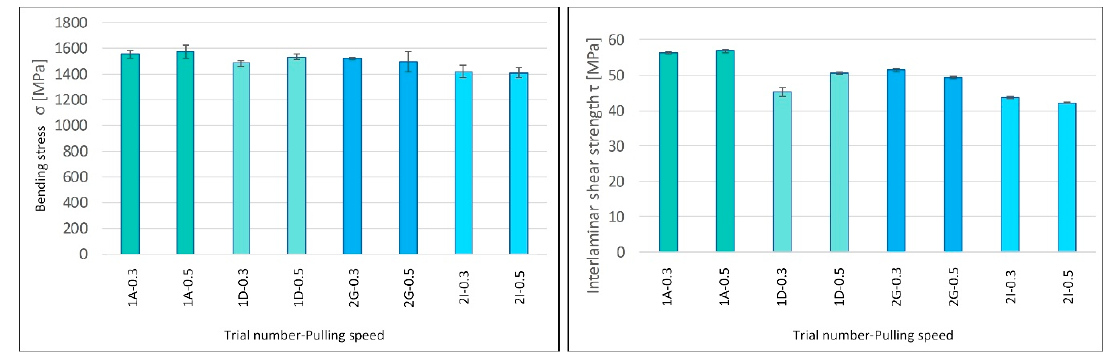
Figure 11. Comparison of pultrusion tests by bending stress ( left ) and interlaminar shear strength ( right ): Impregnation with open bath (label 1) and CIP (label 2): Mixing time of the resin directly before the experiments with two pulling speeds (0.3 and 0.5 m/min)